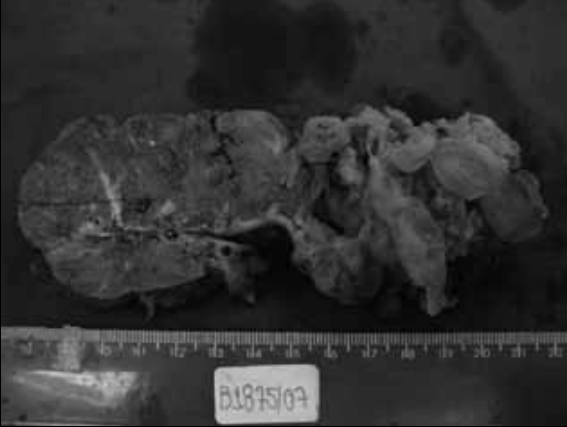
Figura 3 – Imagem microscópica da placenta